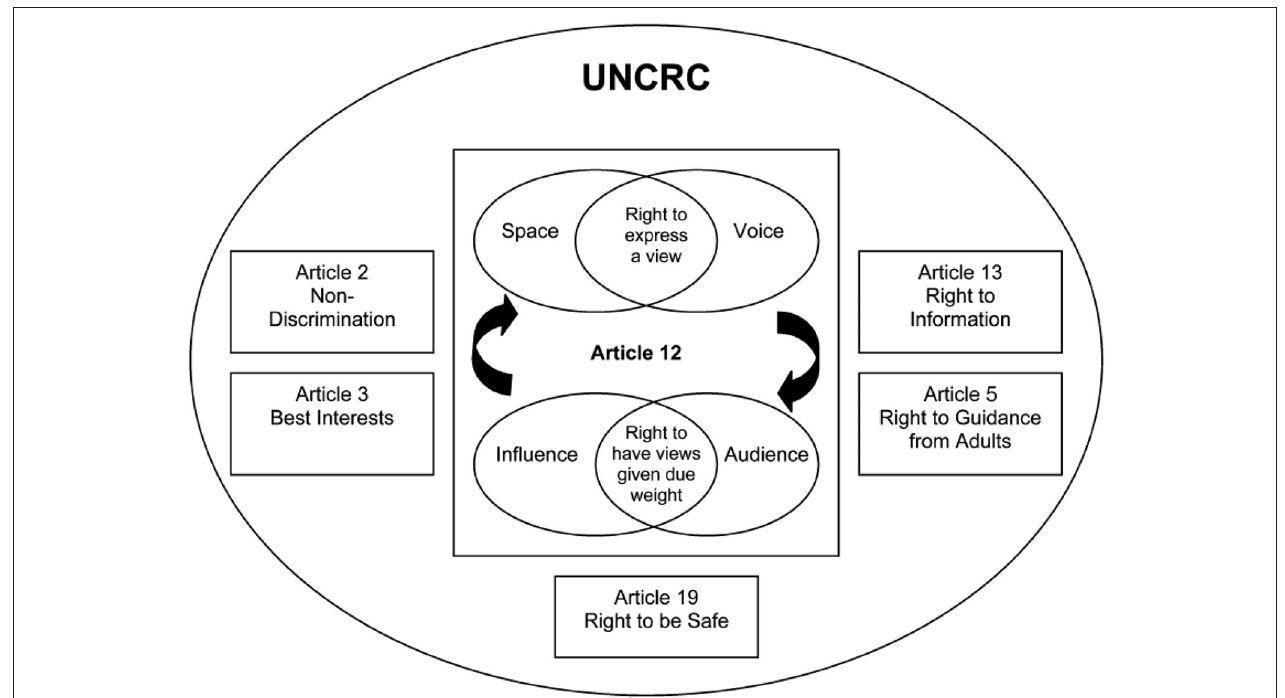
FIGURE 1 | Conceptualising Article 12: Lundy